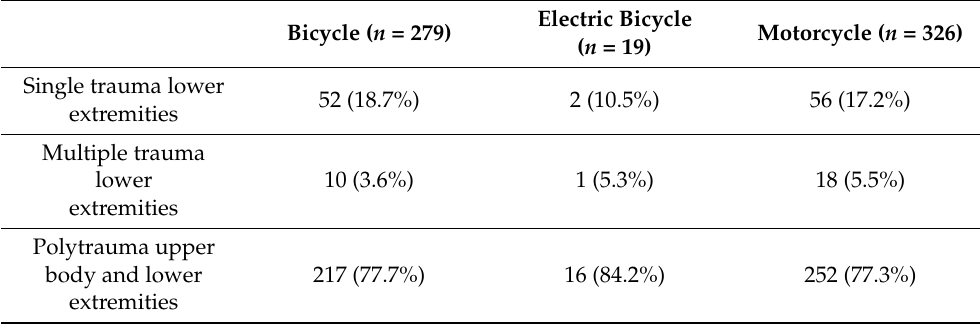
Table 2. Injury pattern stratified by vehicle group.